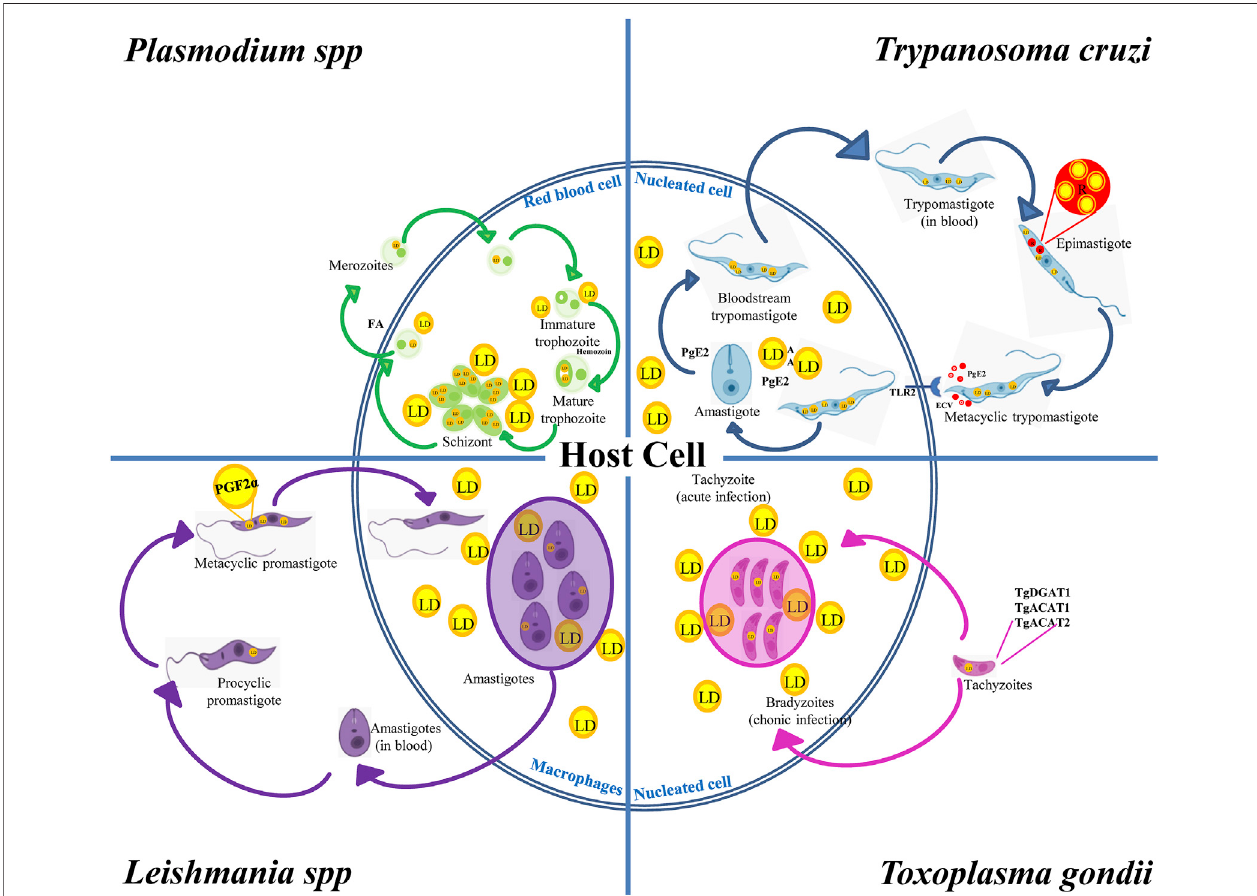
FIGURE 3 | LD in the biological cycles of protozoan parasites. Trypanosoma cruzi displays reservosomes (R) in epimastigotes and cytoplasmic LD in metacyclic trypomastigotes (MT) that mainly store cholesterol and SE, respectively. While degradation of R occurs during metacyclogenesis, the contact with the host cell induces the production of LD and PGE2 in MT and in the host cell favoring T. cruzi infection and replication. Toxoplasma gondii expresses TgDGAT1, TgACAT1 and TgACAT2, whicharetheenzymesresponsiblefortheLDsynthesisintheparasite.AnincreasednumberofhostLDwasobservedincellscontainingvacuoleswithtachyzoites, which is the characteristic parasite stage of the acute infection. These LD are also observed in the vacuole lumen and inside the parasite cytoplasm, thus evidencing the transport of host lipids to the parasite. Leishmania spp. increases the LD number during the evolution from procyclic to metacyclic promastigotes, which also contain PGF2 α , suggesting a role of this eicosanoid as a parasite virulence factor. Host ’ s LD are also increased in macrophages infected with Leishmania . Like T. gondii , these host LD have been observed inside the Leishmania vacuole and even in the parasite ’ s cytoplasm. Plasmodium was found to store NL in the food vacuole. NL are important to prevent heme toxicity by production of the malaria pigment hemozoin. Infected red-blood cells increase the number and size of LD when they evolve from the trophozoite to squizont form, whereas LD breakdown characterizes merozoite maturation and release together with FA.